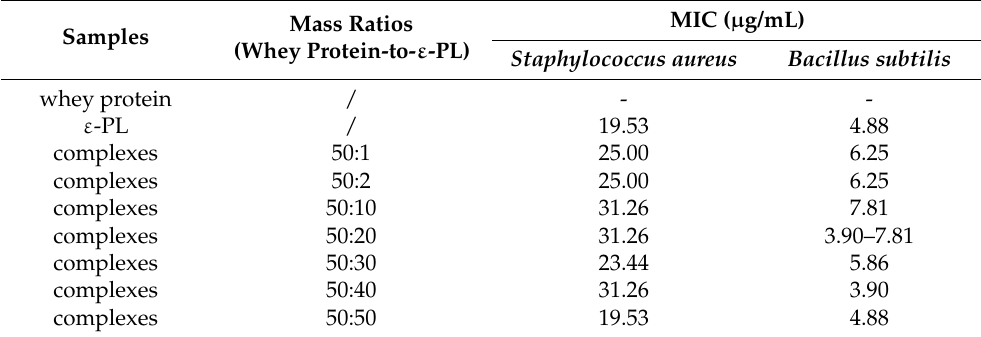
Table 3. The minimum inhibitory concentration (MIC) of whey protein, ε -PL, and whey protein- ε -PL complexes against Staphylococcus aureus and Bacillus subtilis